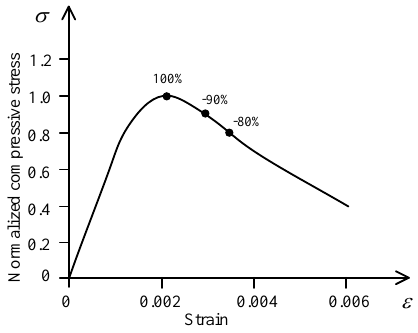
Figure 3. Definition of pre-damage levels (λ).